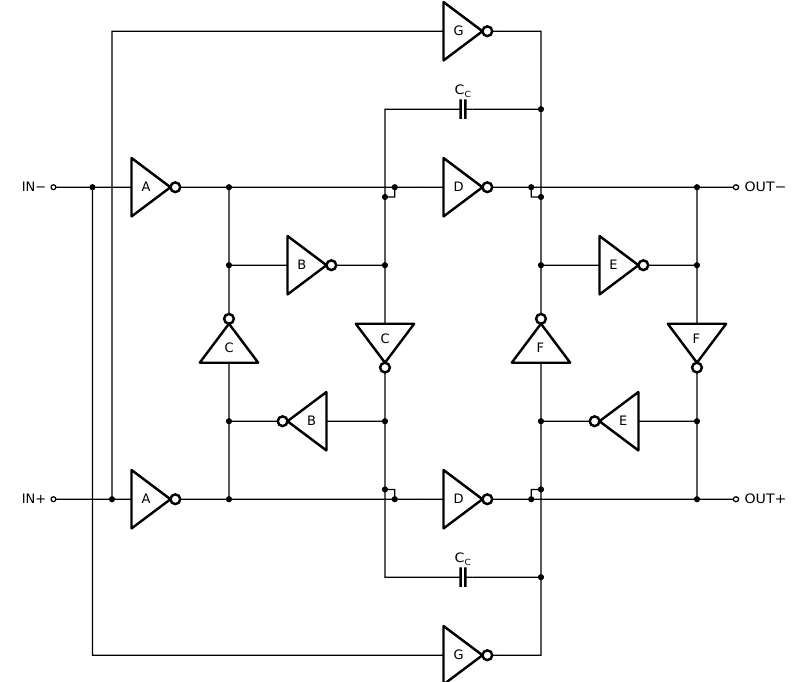
Figure 12. Two-stage Nauta/Nauta (N/N) OTA circuit